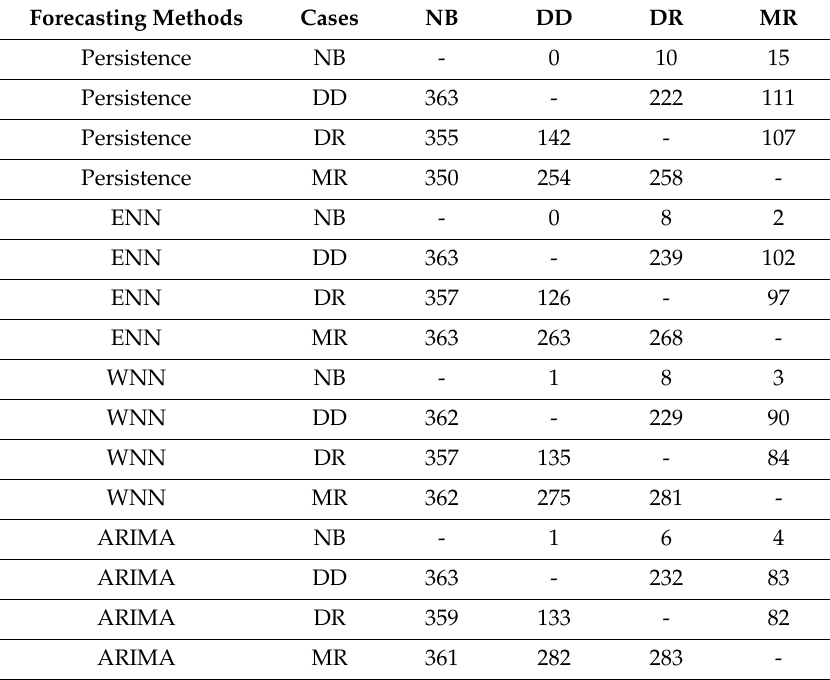
Table 7. The number of days when the case in the row outperforms that in the column using di ff erent forecasting methods.